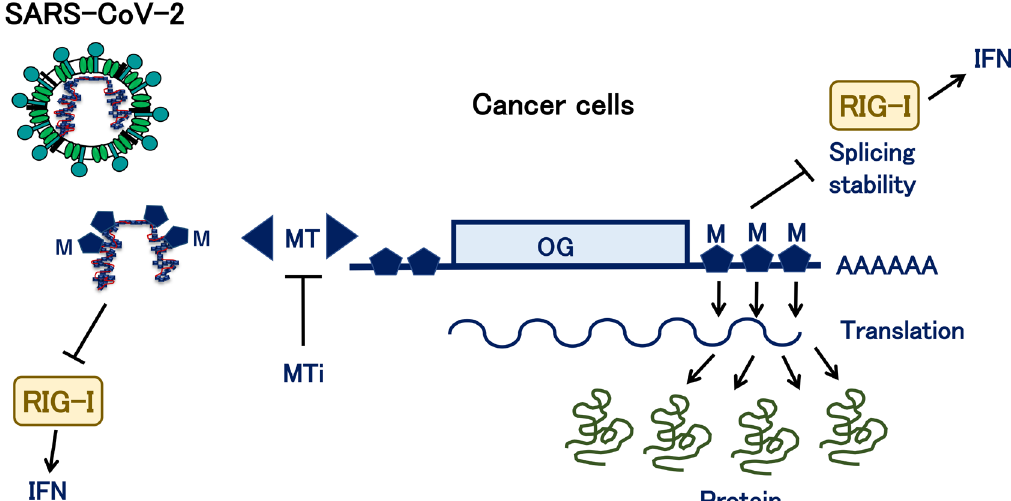
Figure 1. A schematic representation of the parallel involvement of RNA MT in cancer and COVID-19. OG: oncogene; MTi: MT inhibitors; M: methylated residue; A: multiple adenosine monophosphates in poly (A)